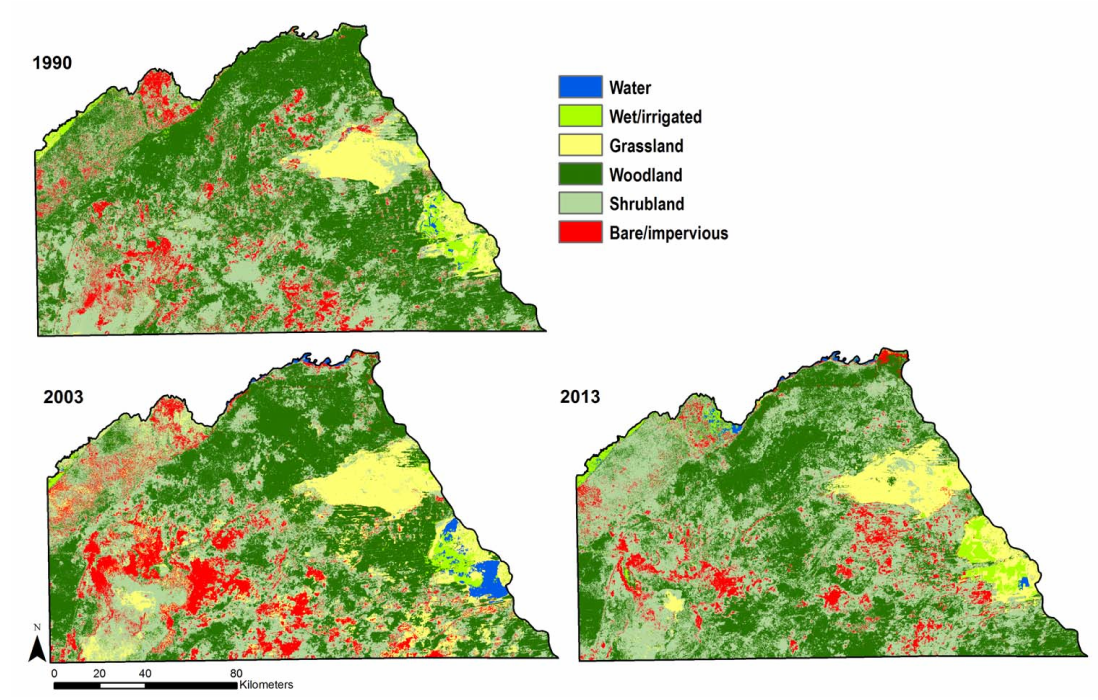
Figure 4. Land cover classification maps of Chobe District for 1990, 2003, and 2013.